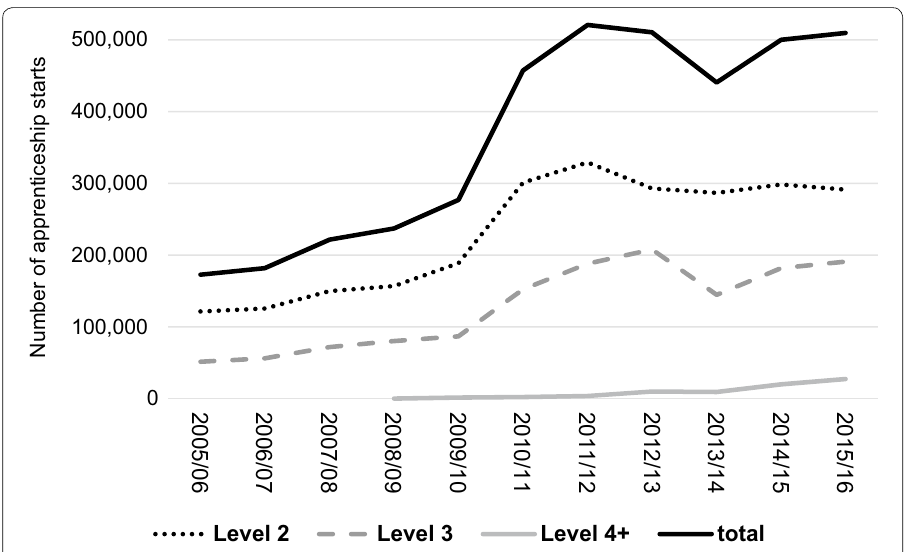
Fig. 4 Apprenticeship starts by level, 2005 to 2014 (Source: skills funding agency statistical first release apprenticeships starts by region, level and